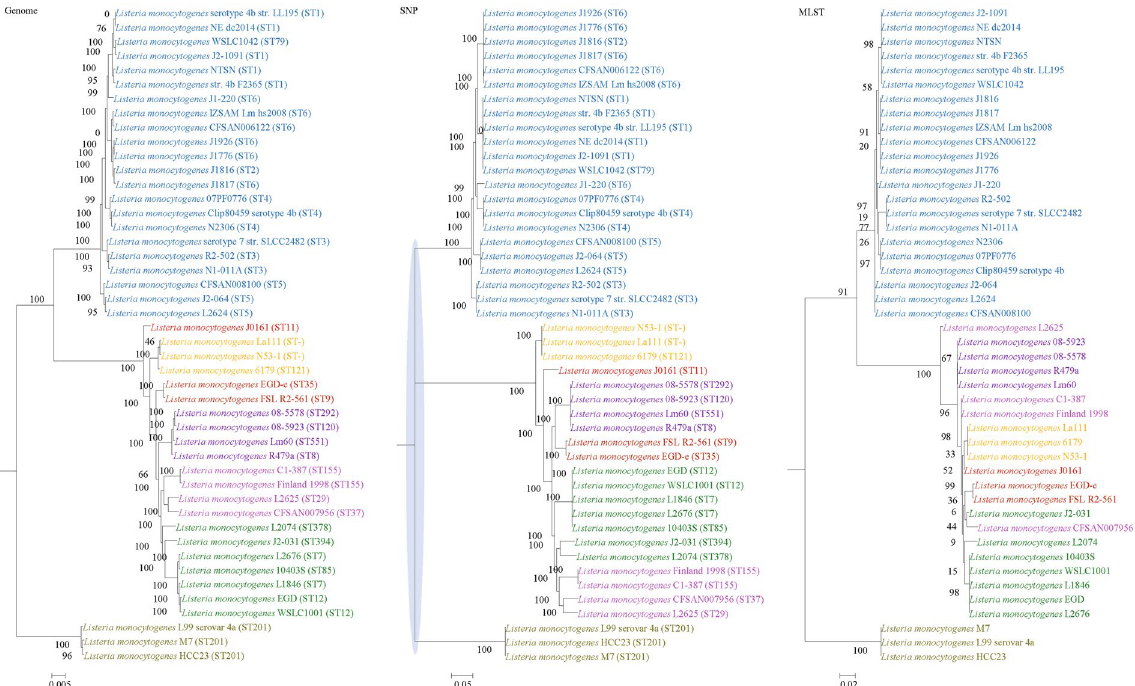
Figure 7. Comparison of phylogenetic trees constructed using genome data (left), SNP data (middle), and MLST data (right) for Listeria monocytogenes . Clusters that were manually selected based on the genome trees are illustrated in different colors. The unresolved polytomies are shaded in blue. A new sequence type is represented by a dash